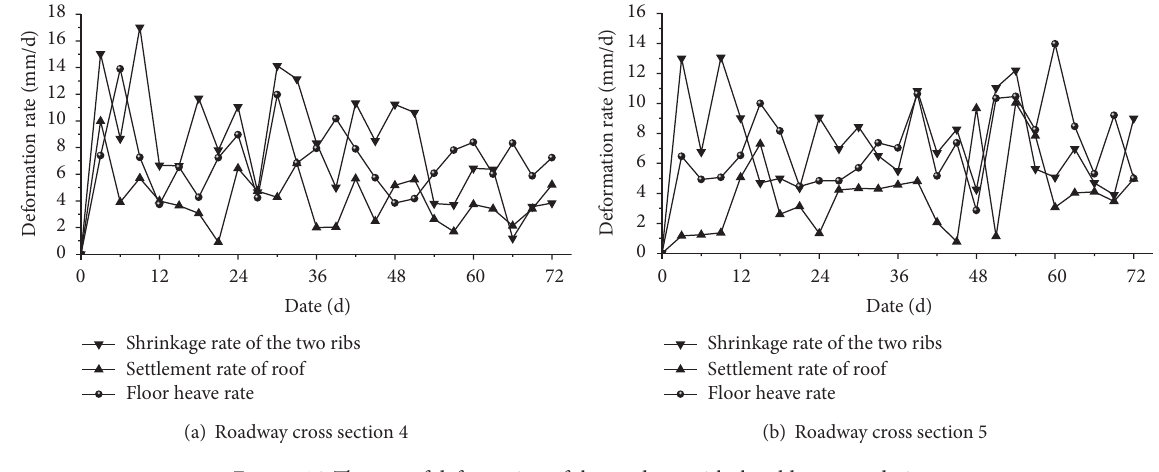
Figure 16: The rate of deformation of the roadway with the old support design.